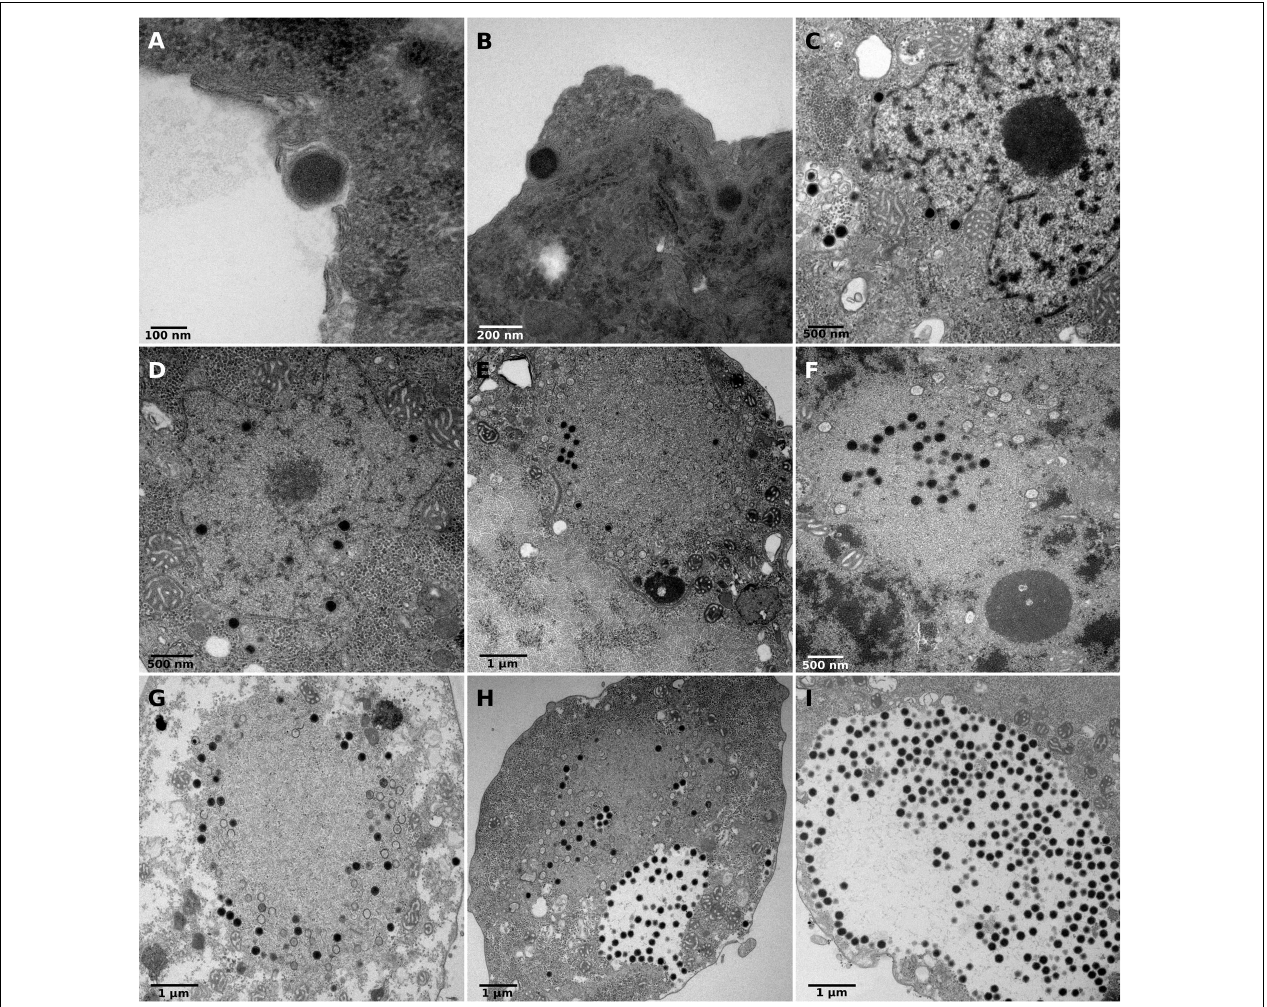
FIGURE 1 | Replicative cycle of clandestinovirus. Scale bars are indicated on each panels. (A,B) Entry of the virus into Vermamoeba vermiformis by phagocytosis at 4 hpi. (C,D) Migration in the cytoplasm to the nucleus and entry into the host nucleus at 7 and 8 hpi. (E–G) Shows the replication of clandestinovirus in the nucleus which became a viral factory at 10 hpi (E) and 12 hpi (F,G) . (H,I) Accumulation of mature viral particles at 11 and 12 hpi.